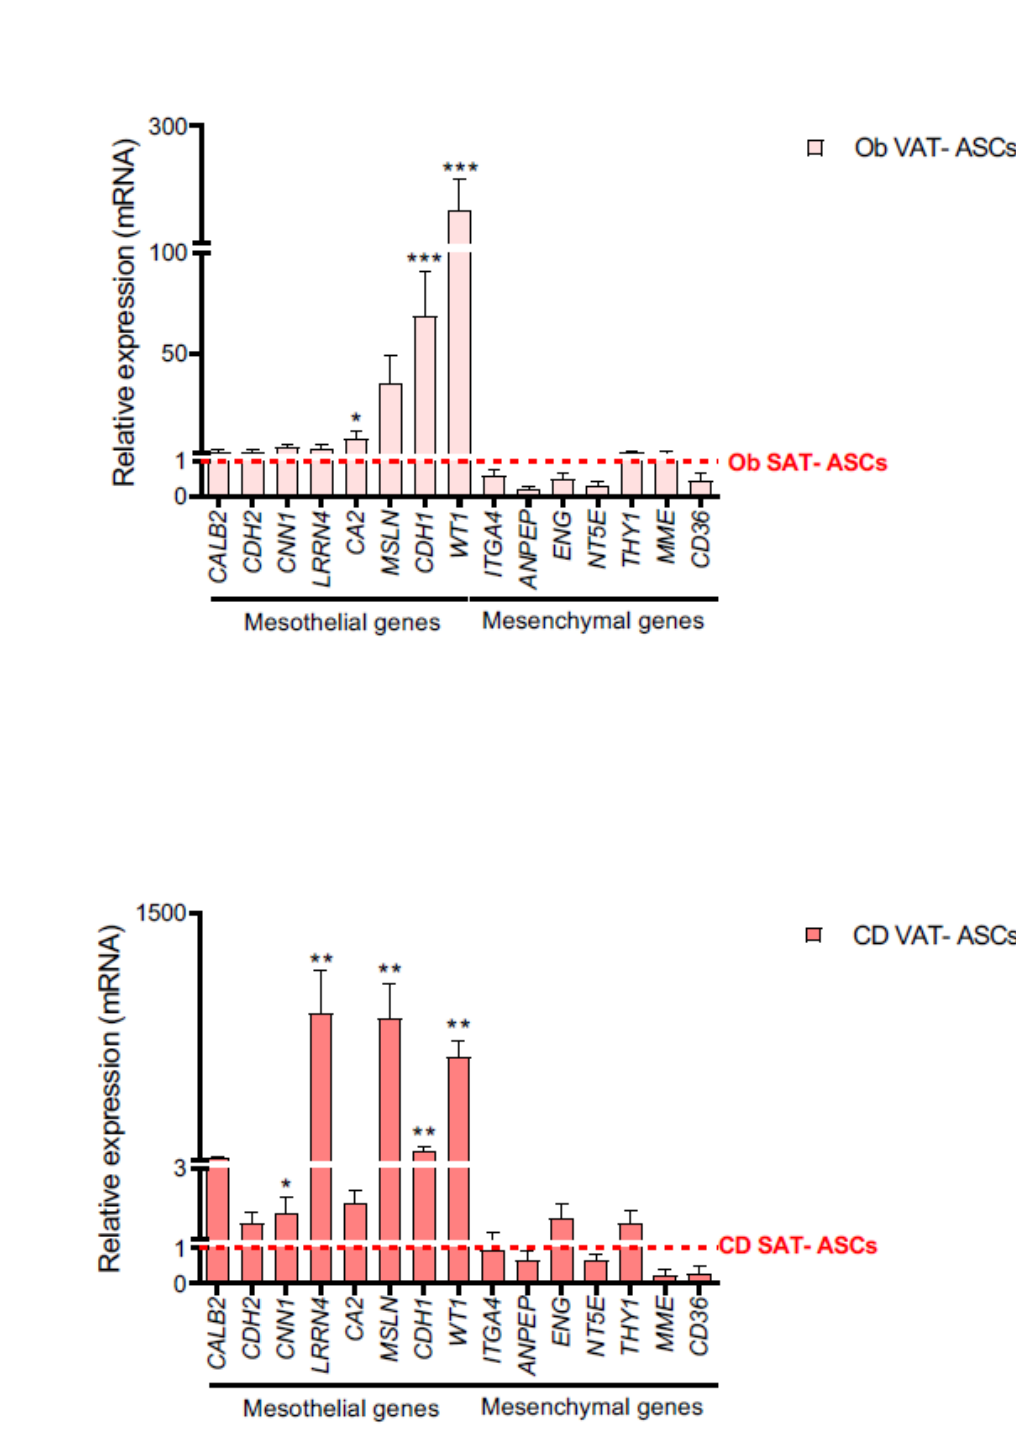
Figure 3. Mesothelial markers are upregulated in obese and Crohn’s disease VAT-derived ASCs with respect to SAT-derived ASCs. qPCR analysis of mesothelial and mesenchymal marker gene expression in VAT-derived ASCs versus SAT-derived ASCs in ( A ) obese (ob VAT n = 4, except n = 10 for LRRN4 , MSLN , KRT8 , CDH1 , WT1 , CDH2 , and CA2 ; ob SAT n = 8), and ( B ) Crohn’s disease (CD VAT n = 13, except n = 28 for LRRN4 , MSLN , KRT8 , CDH1 , WT1 , CDH2 , and CA2 ; CD SAT n = 4). Mean SAT values were normalized to 1, and are represented as a red dotted line. Green-red scale is used where green indicates higher expression and red lower expression. Abbreviations: CD, Crohn’s disease; SAT, subcutaneous adipose tissue; VAT, visceral adipose tissue. Data are expressed as mean ± SEM; * p < 0.05; ** p < 0.01; *** p < 0.001 (Mann-Whitney U test).